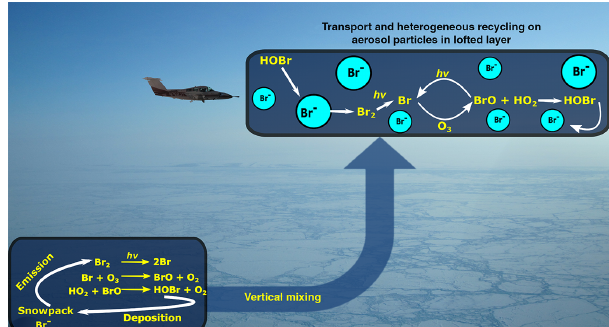
Figure 1. Overview of processes observed in this study. Bromide (Br − ) is converted to reactive bromine (e.g., Br 2 , BrO, and HOBr) through heterogeneous reactions occurring in the surface snowpack leading to the release of Br 2 into the overlying atmosphere. This Br 2 undergoes photolysis, creating bromine atoms and leading to ozone depletion. As increased mixing is observed, the bromine-enriched air mass moves aloft. On the day of the flight, we observed sustained BrO levels in a lofted layer concurrent with aerosol particles, indi- cating heterogeneous recycling of reactive bromine aloft, decoupled from the initial snowpack activation